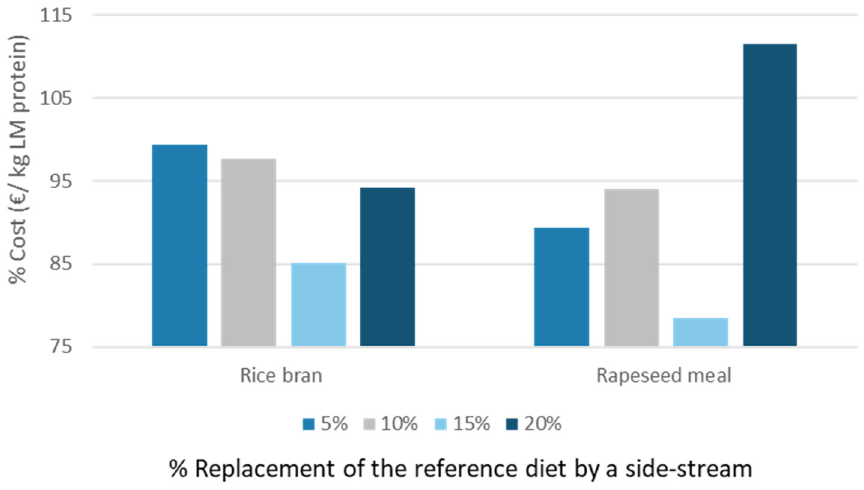
Figure 6. Changes in cost price producing LM larvae proteins with diets 9–16 compared to the reference